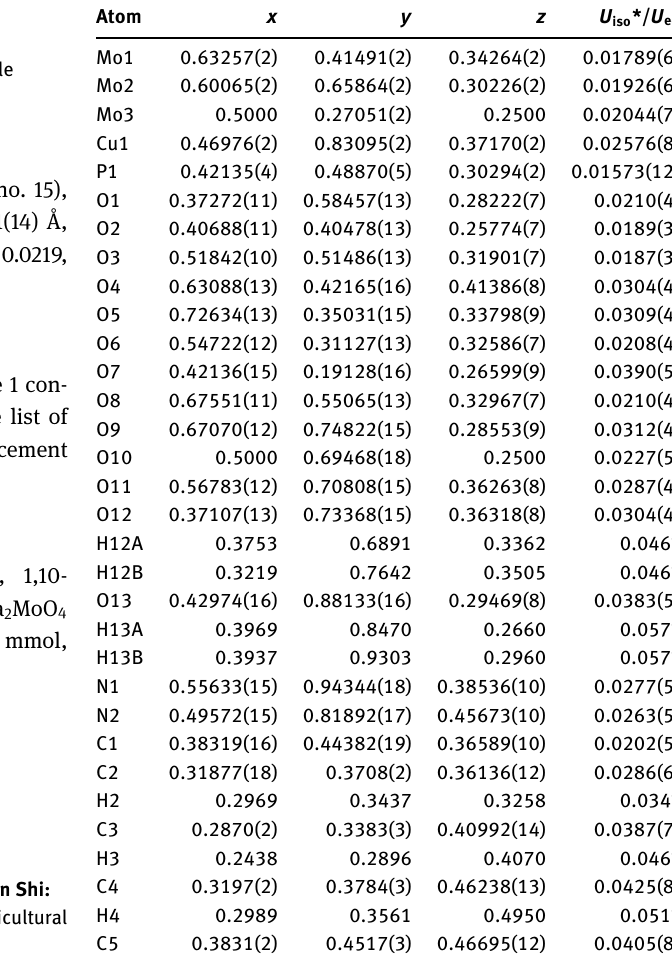
Table 2: Fractional atomic coordinates and isotropic or equivalent isotropic displacement parameters (Å 2